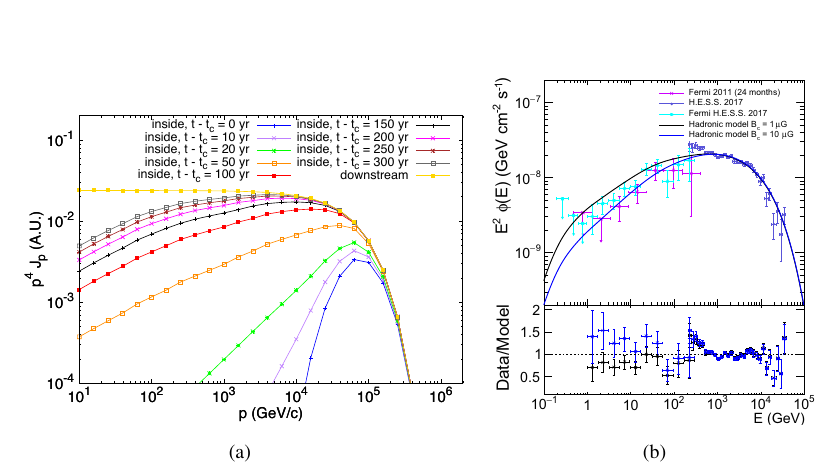
Figure 1. (a) Proton spectrum inside clumps of di ff erent ages. The downstream particle energy density, which is constant in time, is also reported. (b) Gamma-ray flux from SNR RX J1713.7-3946. The points are Fermi-LAT data (pink), H.E.S.S. data (violet) and H.E.S.S. analysis of Fermi-LAT data (light blue). The hadronic models (solid lines) refer to the configuration with a magnetic field inside the clump equal to B c = 1 μ G (black) and to B c = 10 μ G (blue). The field in the clump skin is fixed to 100 μ G in both models, to mimic the